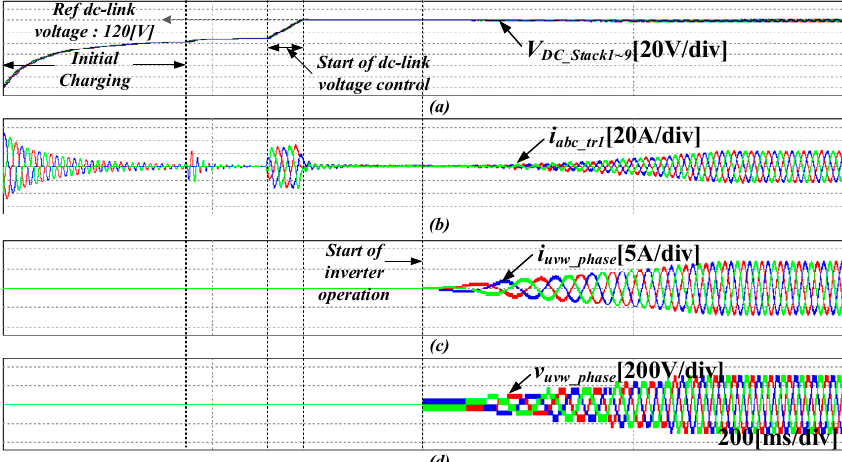
Figure 15. Simulation results of the 13-level cascaded NPC/H-bridge system ( a ) DC-link voltage, ( b ) input current of the converter, ( c ) output current of the inverter, ( d ) output voltage of the inverter.